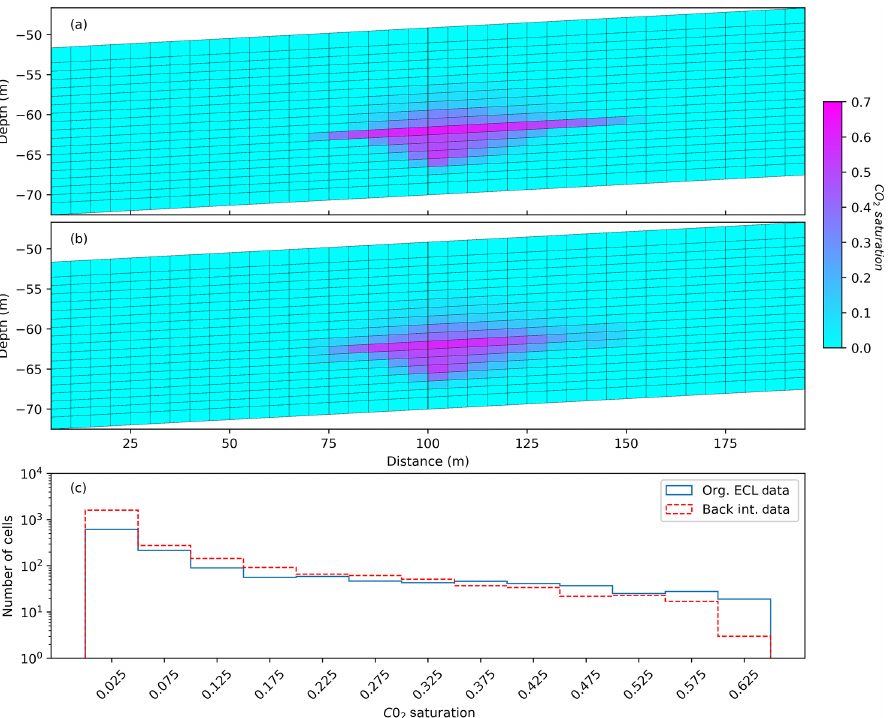
Figure 3. (a, b) Slice through 3D Eclipse reservoir model after the injection of 23t of CO 2 . (a) Original CO 2 saturation data. (b) CO 2 saturation data after interpolating onto the unstructured grid, and then back-interpolating onto the structured Eclipse grid. (c) Histogram showing the CO 2 distribution for original and back-interpolated saturation data. The bin width is 5%.